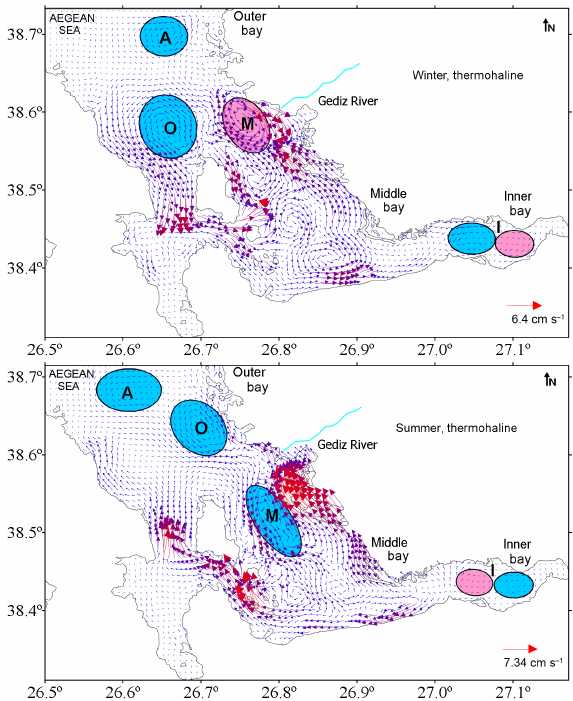
Figure 5. The barotropic current pattern (depth averaged) in the case of westerly wind in winter and in